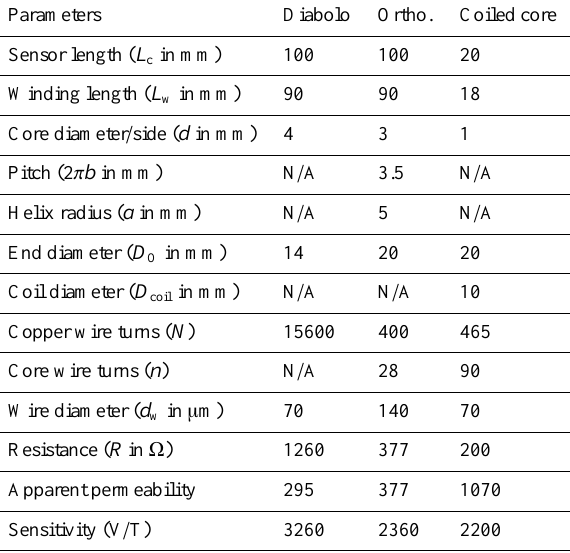
Table 2. Design parameters for diabolo, orthogonal and coiled-core √ induction sensors for an equal NEMI goal: 2pT / (Hz) at 10Hz, √ √ assuming e PA = 4nV / (Hz) and i PA = 20fA /